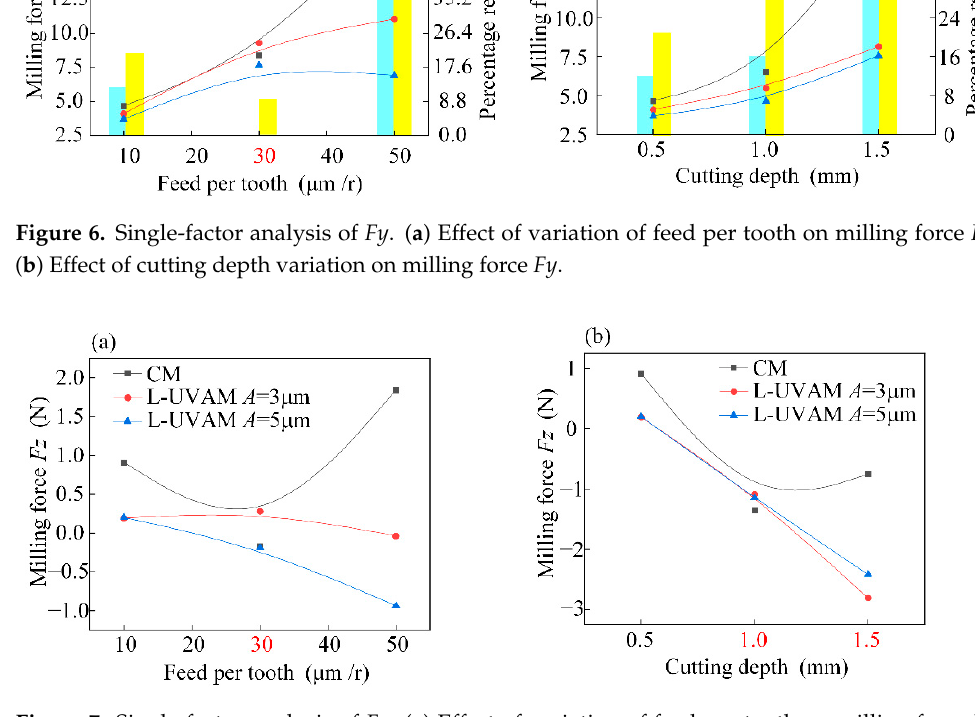
Figure 7. Single-factor analysis of Fz . ( a ) Effect of variation of feed per tooth on milling force Fz ; ( b ) Effect of cutting depth variation on milling force Fy.